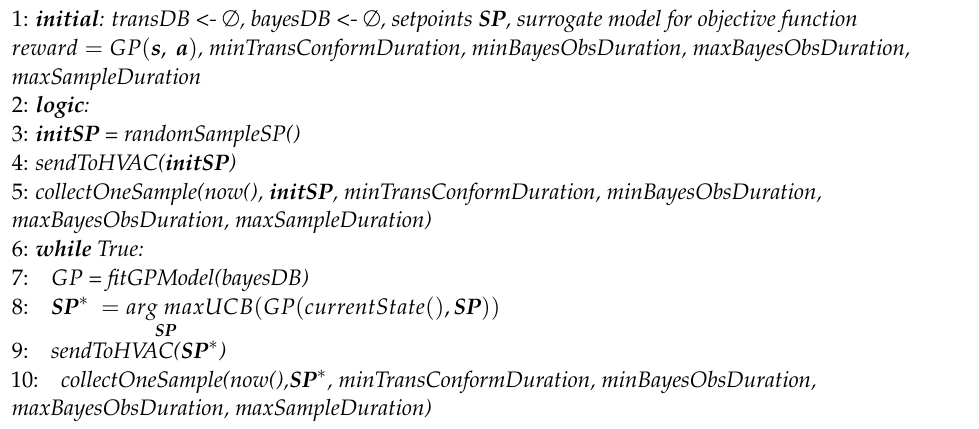
Algorithm 4: Basic process of Bayesian optimization control loop for HVAC